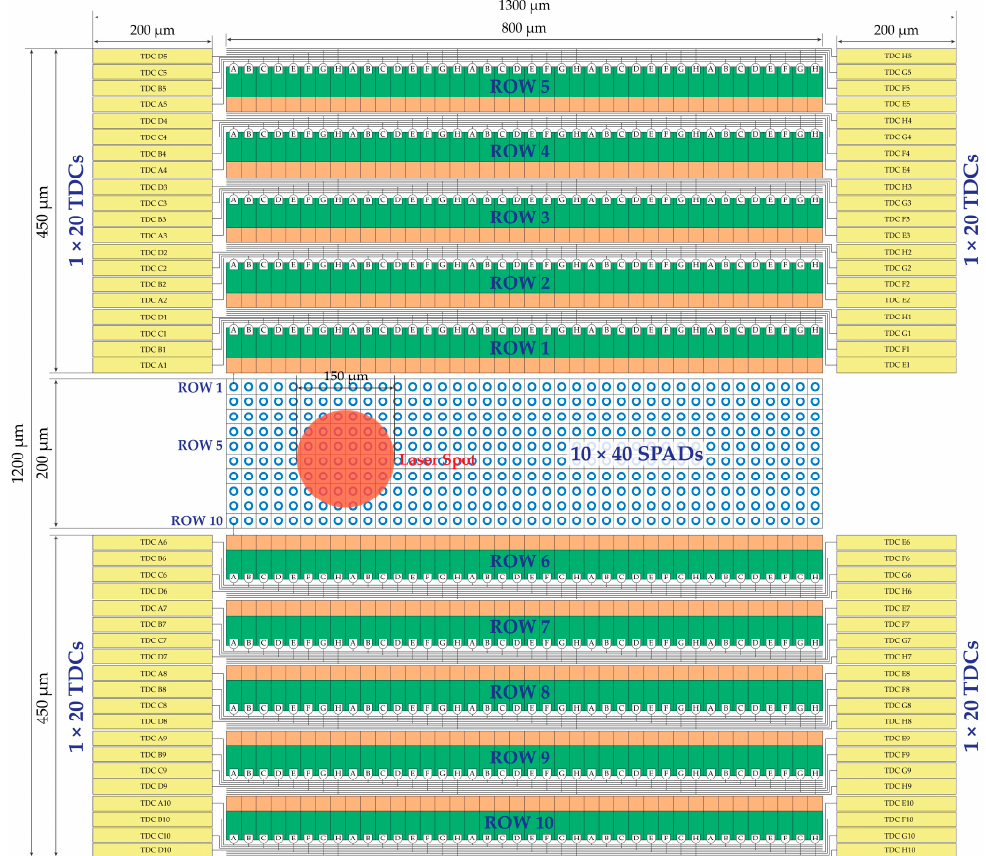
Figure 16. SPAD and TDC arrays blocks layout of the TOF chip; note that the global electronics, storage memory, data processing, and read out circuitry are not shown.